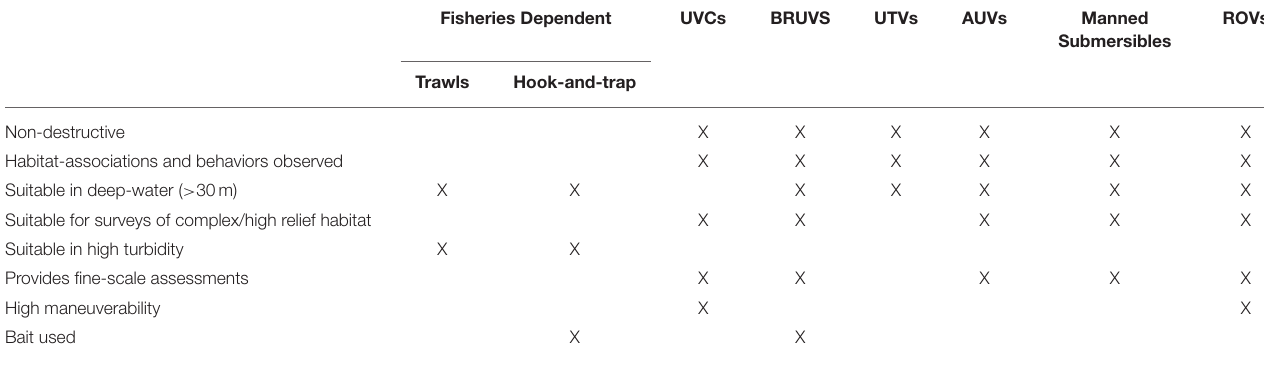
TABLE 4 | Differences in method application and the advantages and disadvantages of each method when compared with